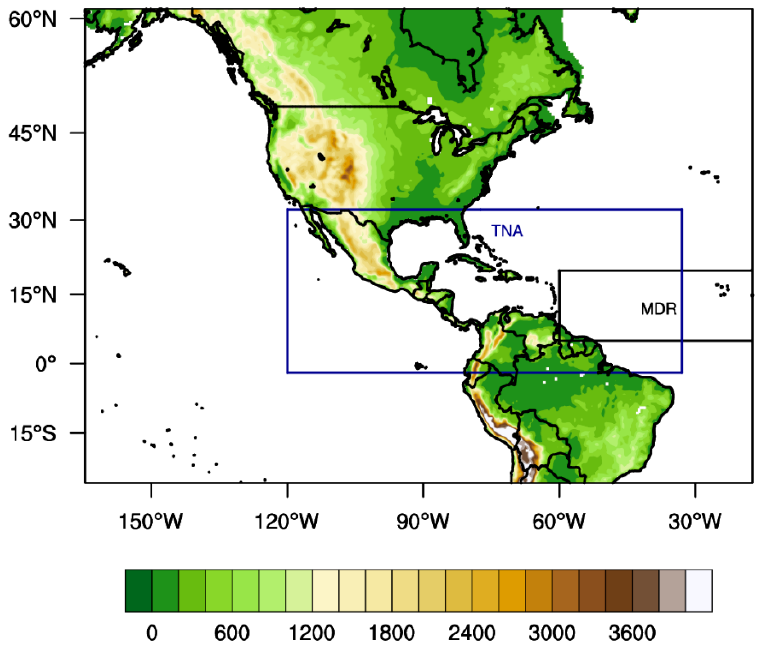
Figure 1. Regional climate model domain. Model terrain height (m) and the two study regions: Tropical North America (TNA) and Main Development Region (MDR).